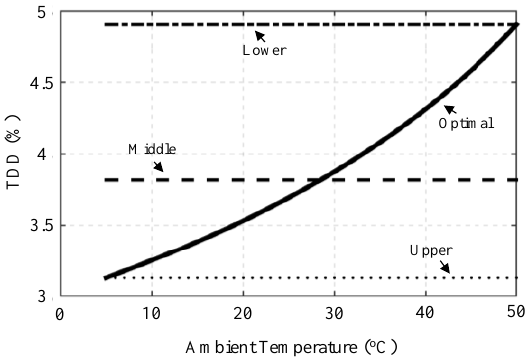
Figure 8. Optimal switching frequency and junction temperatures versus ambient temperature for different switching frequencies, ( a ) optimal switching frequency in kHz; ( b ) IGBT junction temperature under different switching frequencies; ( c ) diode junction temperature under different switching frequencies.